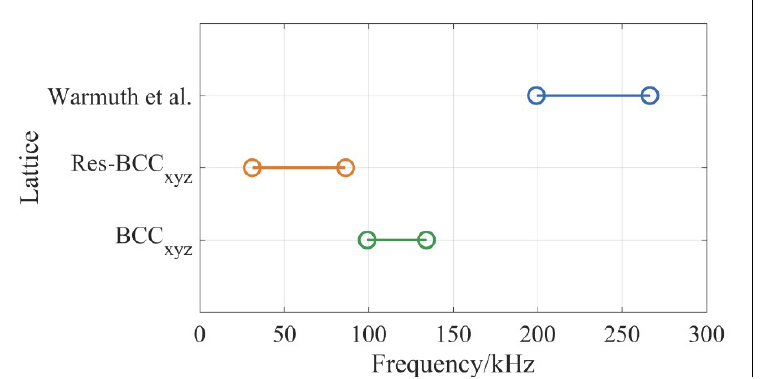
Figure 11. BG properties of the BCC xyz , res-BCC xyz and Warmuth et al. [30] lattices of 20% volume fraction and 10 mm unit cell size, as predicted using the material properties of Ti-6Al-4V.